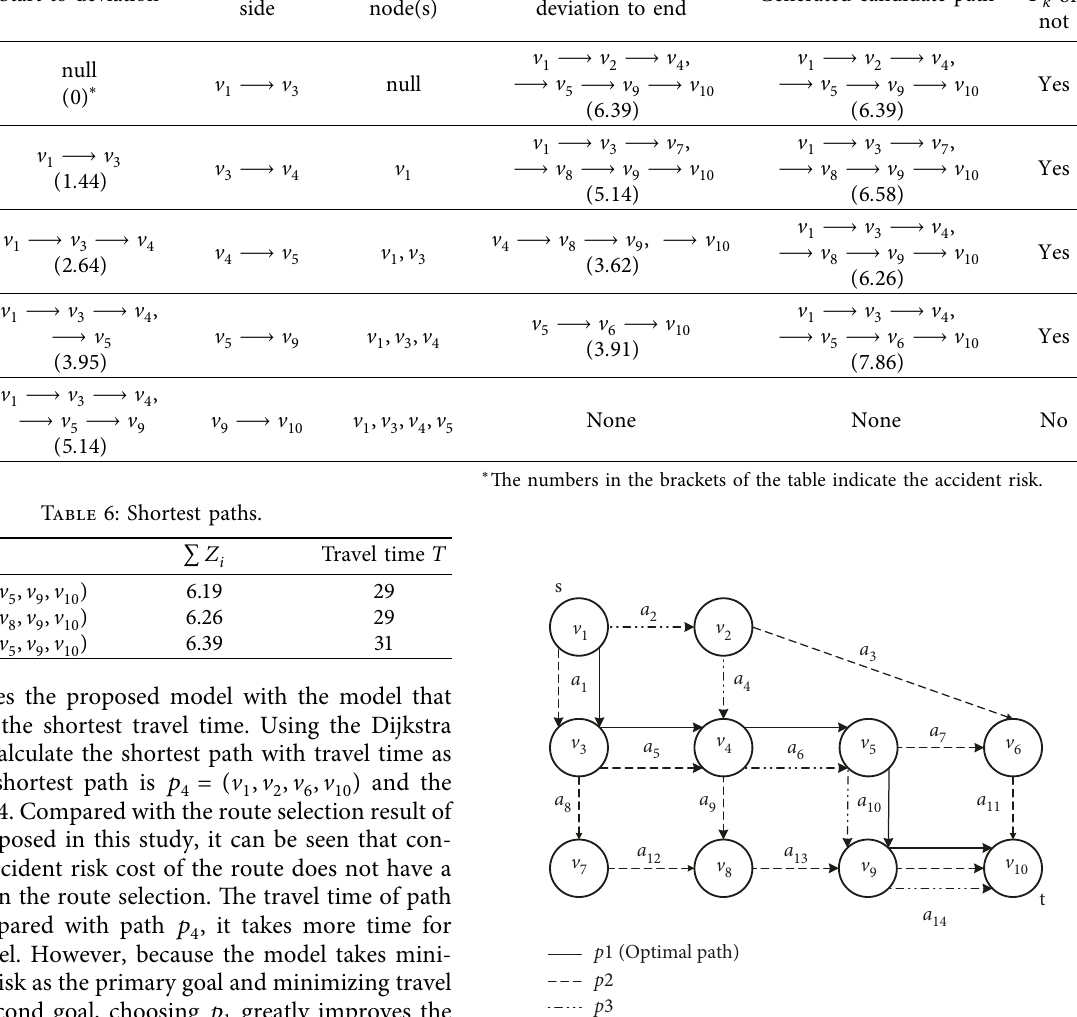
Table 5: Deviation path algorithm.